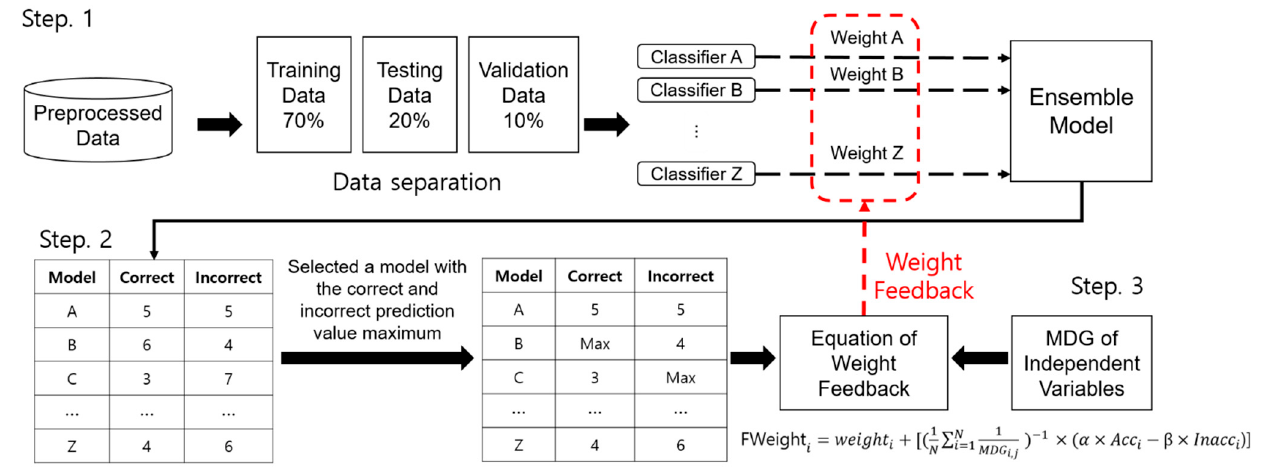
Figure 6. The structure of the weight feedback based harmonic MDG-ensemble model.